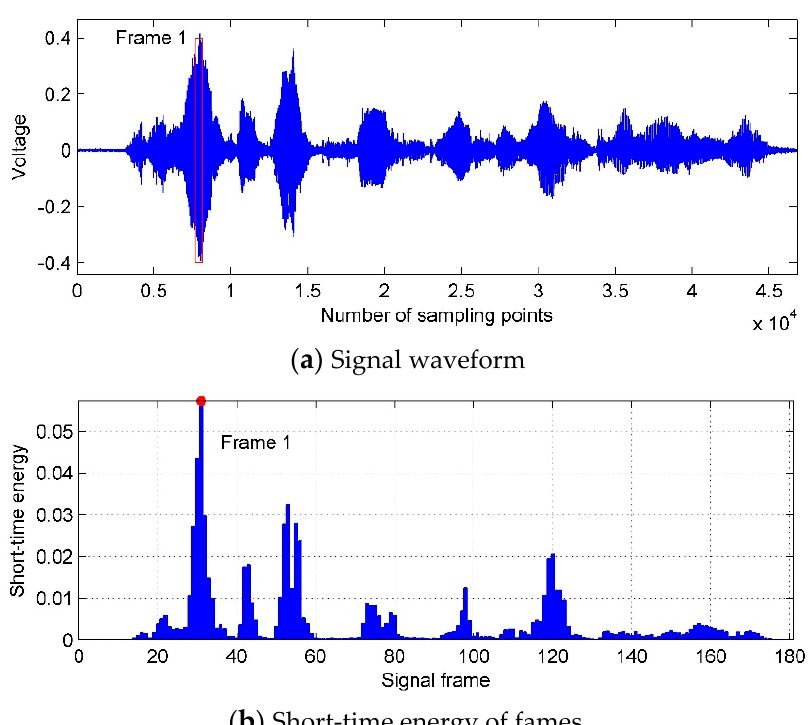
Figure 4. Voice signal with SNR as 30 dB and reverberation as 300 ms.